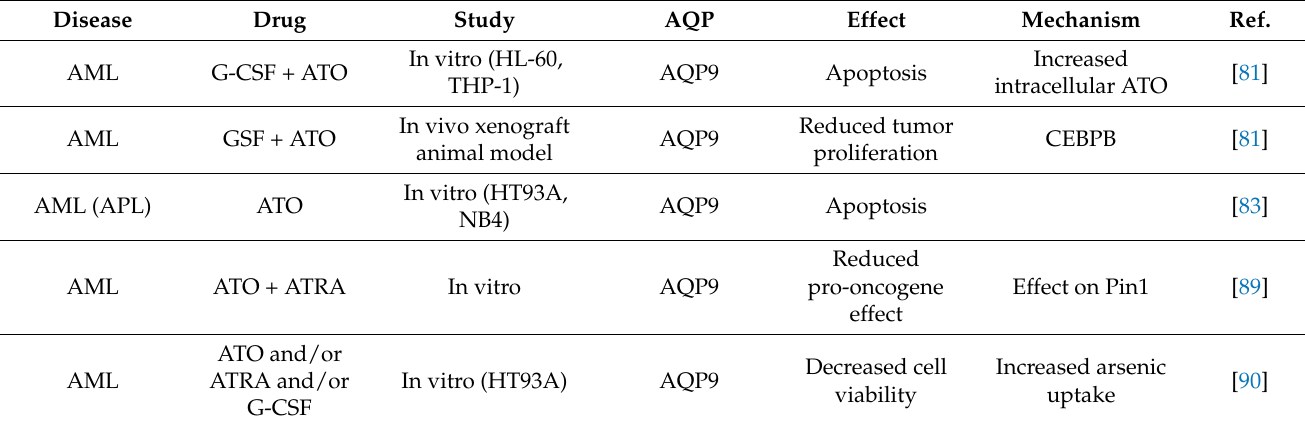
Table 1. Involvement of AQP9 in the response to drugs employed for the treatment of acute myeloid